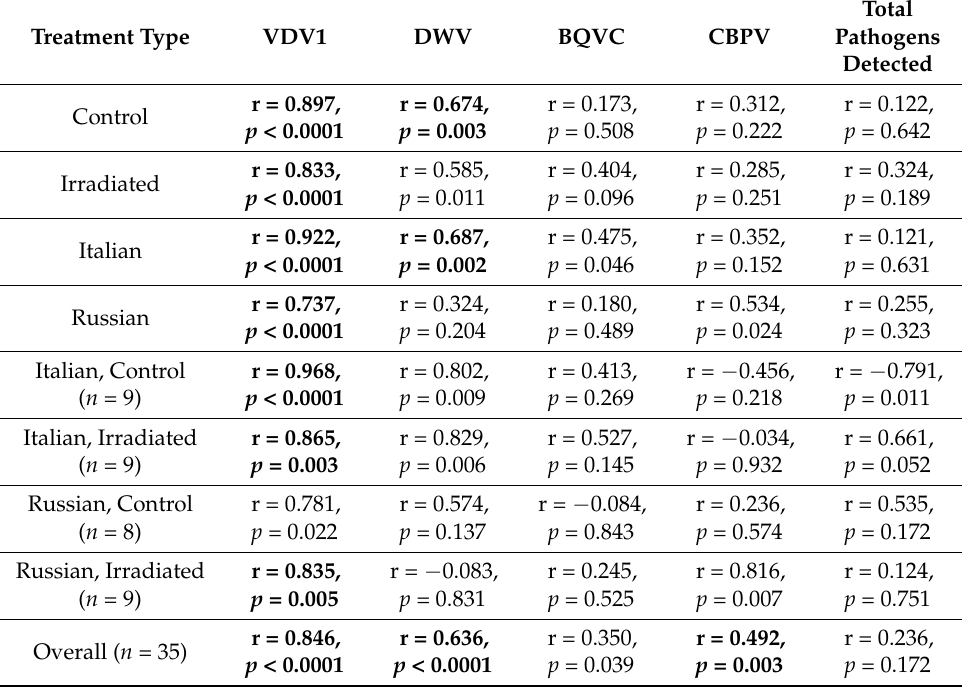
Table 1. Summary of correlation analyses for viral and total pathogen levels in Varroa and their respective infested pupae. With Bonferroni correction, a p -value < 0.006 indicates significance as indicated in bold type.